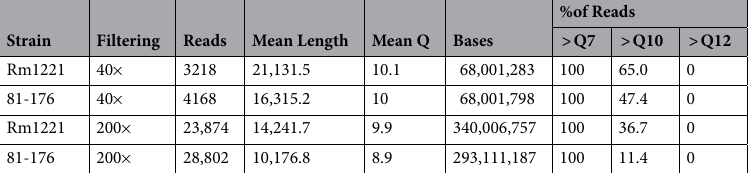
Strain Filtering